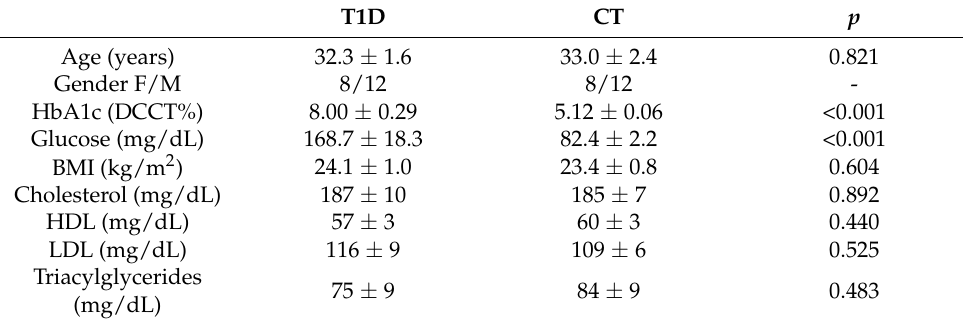
Table 1. Main characteristics of the cohort of T1D patients.